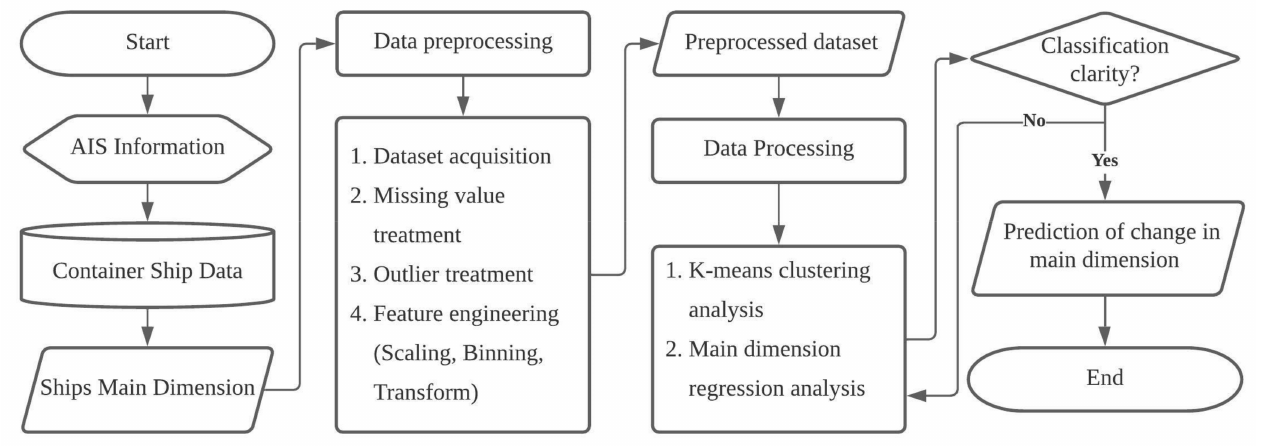
Figure 2. Flowchart of this